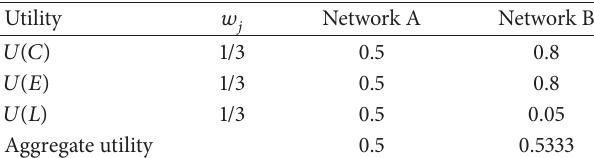
Table 2: Network selection based on TOPSIS.